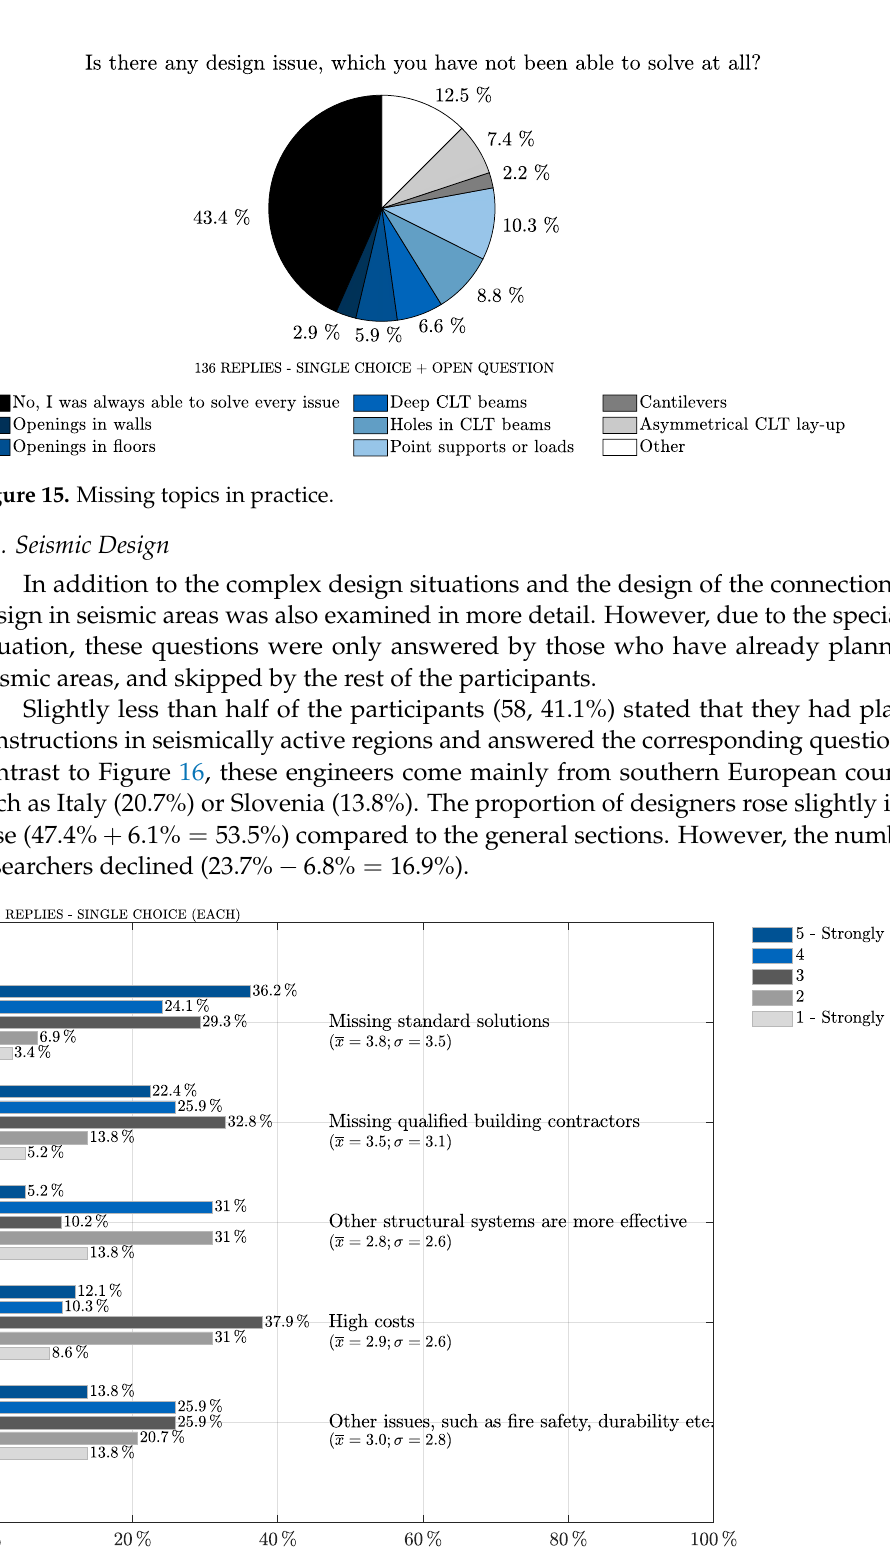
Figure 16. Reasons why CLT or hybrid (CLT-concrete) structures are not commonly used for high-rise buildings in seismically active